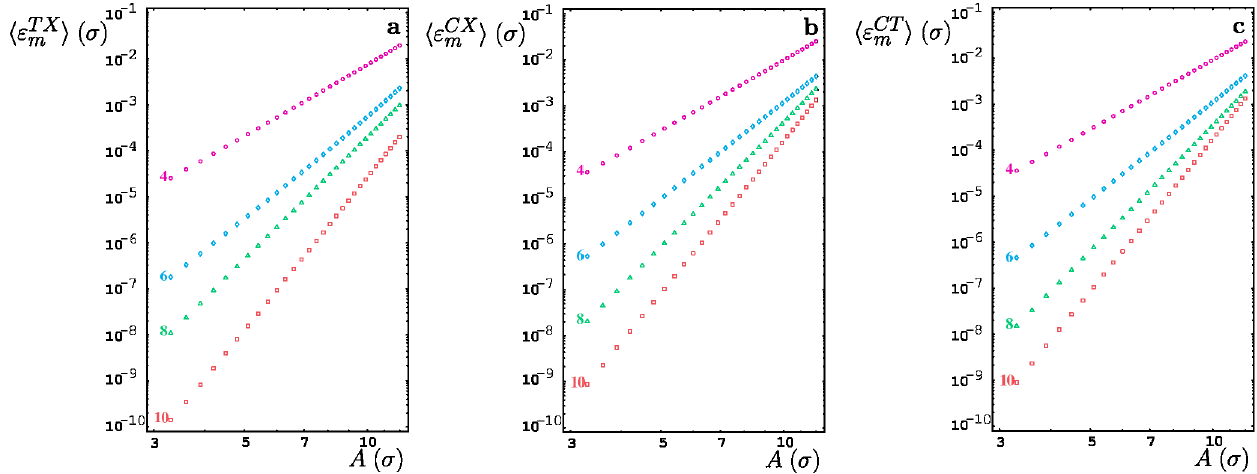
i versus amplitude, parametrized by map order m (indicated by 10, 8, 6, and 4 in the FIG. 6. (Color) Average one-turn error h " (cid:27) m figure), for a relative momentum deviation (cid:29) (cid:1) 0 . The different plots show results averaged over an orbit of 1000 turns for the one- turn error between (a) direct and Taylor map tracking, TX , (b) direct and Cremona map tracking, CX , and (c) Taylor map and Cremona map tracking, CT .